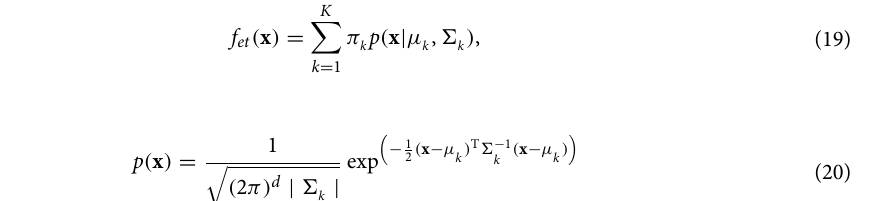
Stage 3: classification based on the squared Mahalanobis distance criterion. Classifier determi‑ nation. The squared Mahalanobis distance classification criterion-based diagnostic methodology, consisting of the five sequential steps as shown in the flow chart (Fig. 8A), is proposed to diagnose HS s and is described in the following 5